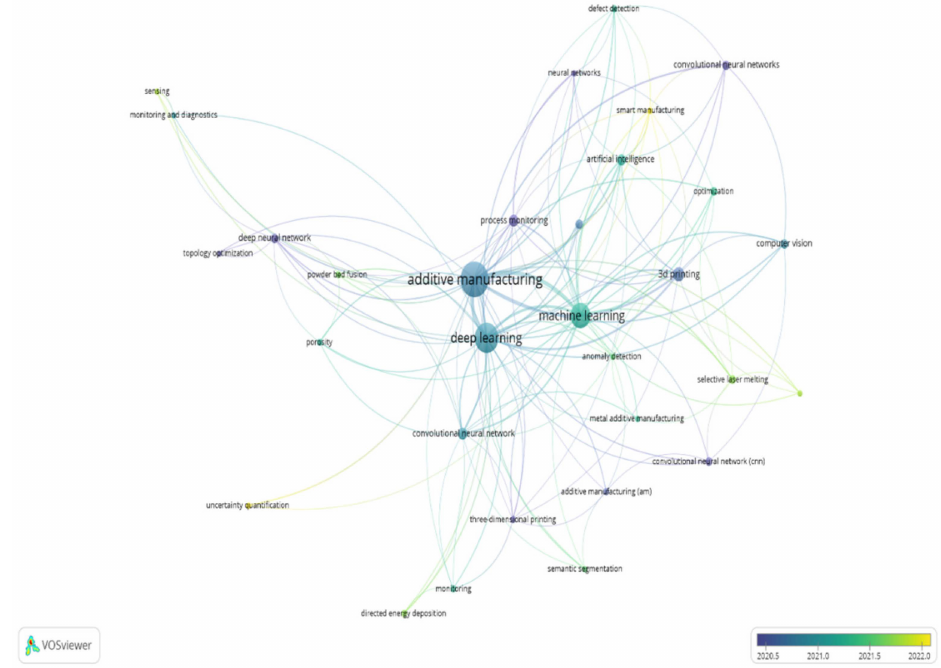
Figure 3. Network, co-occurrence, and density visualization of various associated keywords.